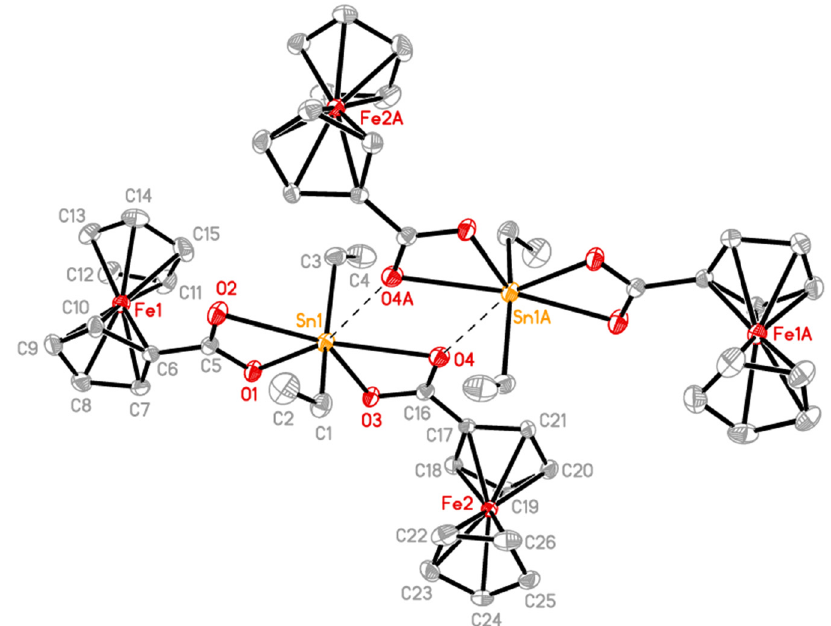
Figure 1: The molecular structure of 1 . Ellipsoids are drawn at the 30% probability level. Hydrogen atoms are omitted for clarity. Symmetry code A : 1/2 − x , 1/2 − y , 1 − z